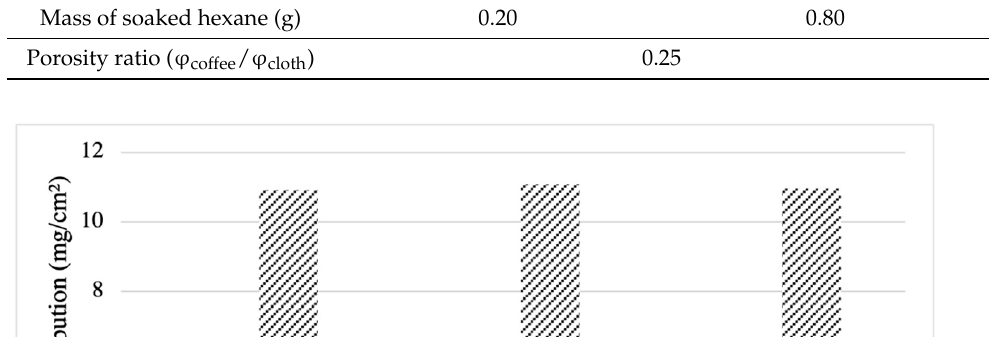
Figure 8. Percent RGB similarity as a function of time. 3.4. Structure of the Oxide Coating Determined by XRD XRD was used on another batch of sol–gel, synthesized for the purpose of examining the phase of TiO 2 . This batch of sol–gel was treated in the same manner as those used in the previous trials. The sol–gel samples of all treatment methods were found to contain amorphous phase TiO 2 . The additional compounds used in synthesizing the sol–gel, 1 ‐ Butanol, and acetic acid are volatile liquids and were allowed to completely vaporize over a span of 14 days. Therefore, they are not present in the samples. The XRD results shown in Figure 9 do confirm the presence of amorphous TiO 2 with no presence of any crystalline forms of TiO 2 . Despite the lack of anatase phase crystals, the amorphous coating was able to provide favorable oil/water separation properties. This result is promising for scalable production of filters, as amorphous TiO 2 can be formed without requiring additional heat treatment or as much highly sophisticated equipment. If the amorphous coating is able to be further optimized, it is more likely to be imple ‐ mented in oil spill cleanup efforts.